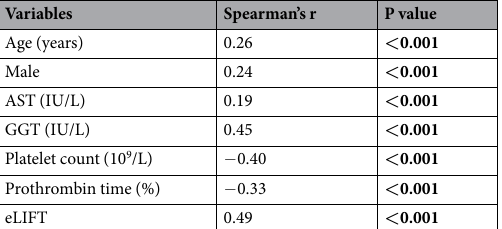
Table 2. Correlations between noninvasive markers and METAVIR fibrosis stages. AST, aspartate transaminase; GGT, gamma-glutamyl transpeptidase; eLIFT, the easy Liver Fibrosis Test; Spearman’s r, correlation